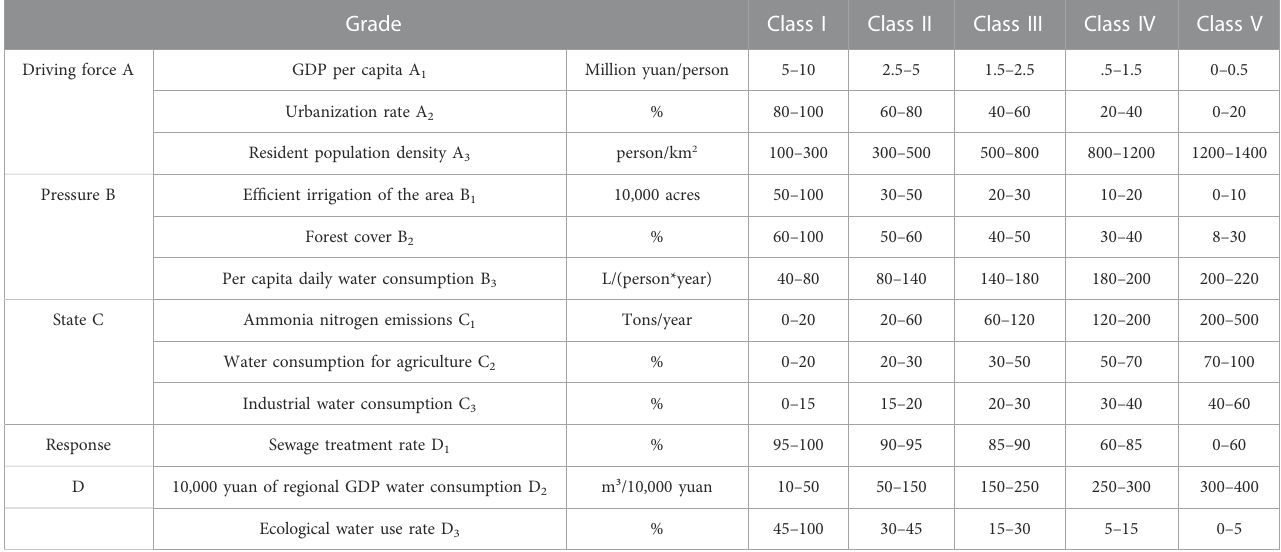
TABLE 10 The threshold of water resource carrying capacity evaluation level based on cloud theory in Chicheng